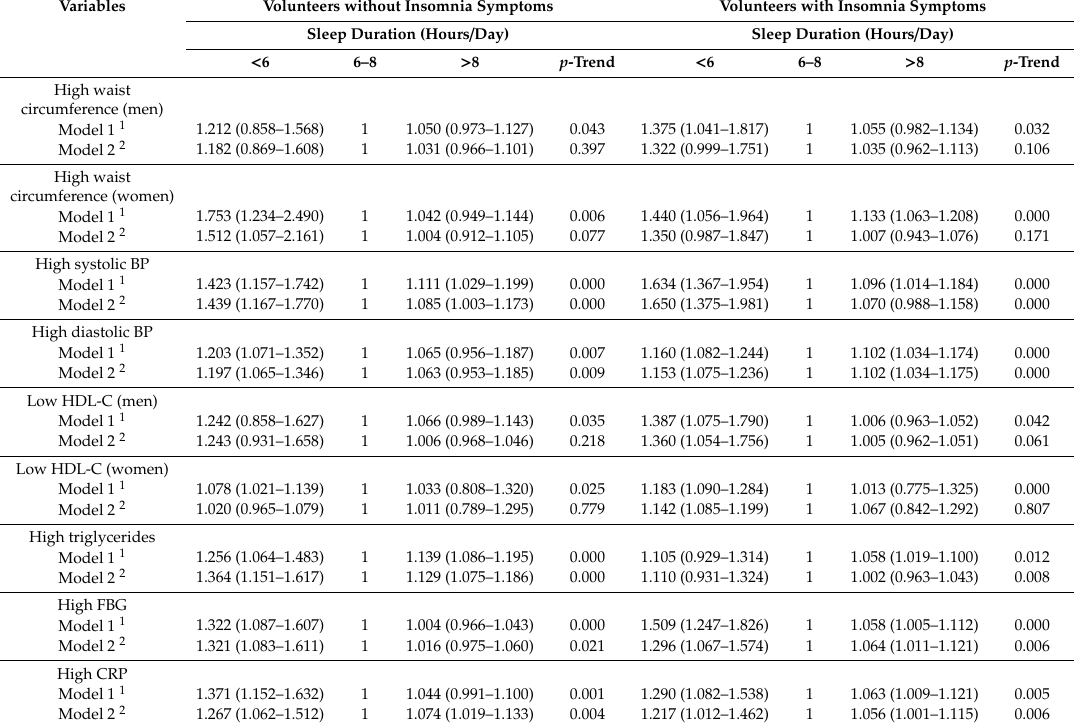
Table 4. Odds ratios (95% CI) of the components of metabolic syndrome and C-reactive protein across volunteers with or without insomnia